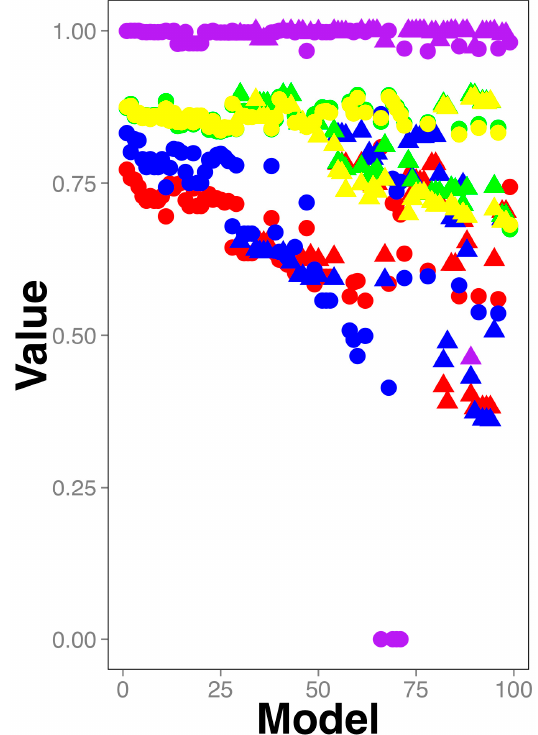
Figure 1. Classifiers performance. Five statistical parameters (yellow circle: Correctly classified instances in the test set after 67% of split validation of the training set; green circle: 10-fold cross-validation on training set; red circle: Correctly classified instances on the testing set; blue circle: AUROC on the testing set; purple circle: adjusted estimated error rate on the training set where the minimum error was represented by number 1.0) are sorted from highest to lowest values. Hence, the best parameter values are located on the left-upper part of the figure. The models using heterologous data are represented as circles; triangles are used otherwise. The actual data of this plot can be found in Supplementary Table S19.